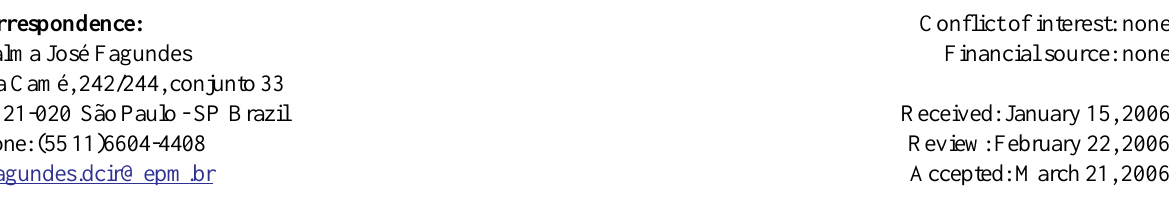
Color figure available from